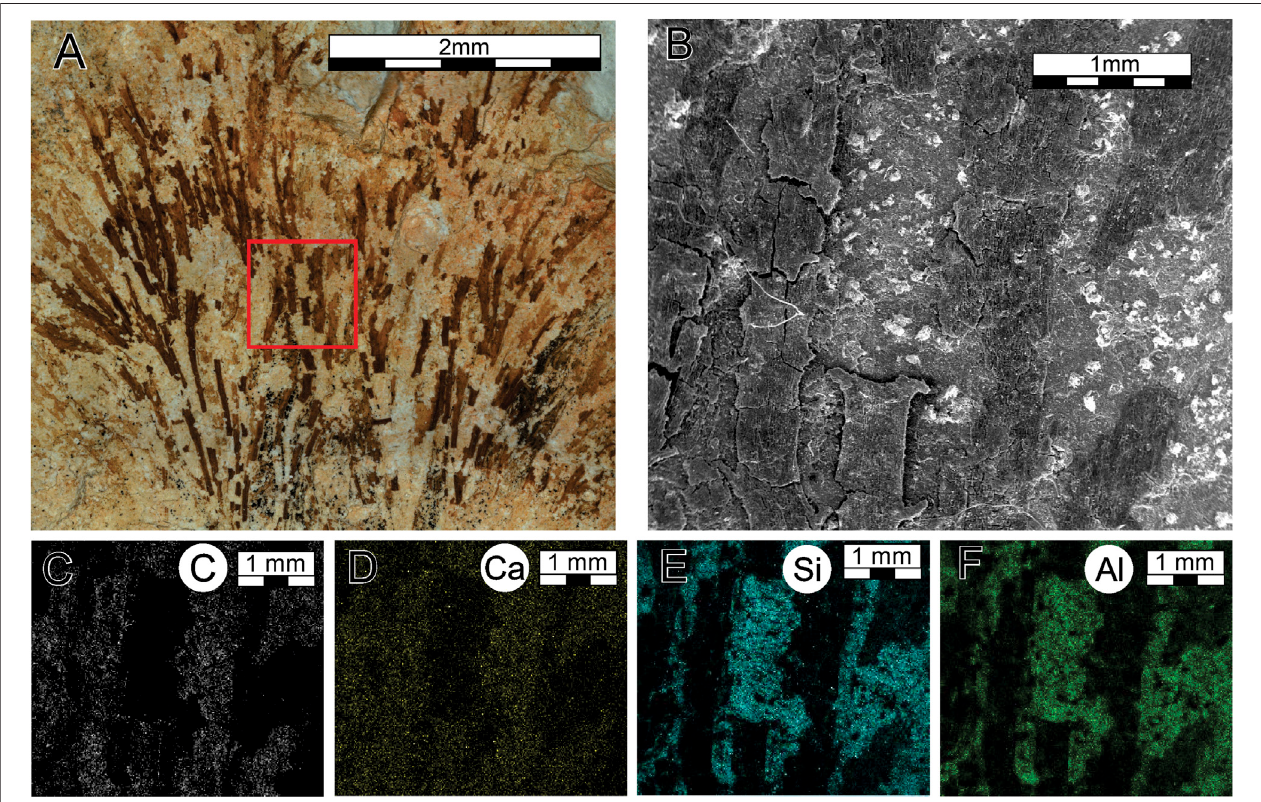
FIGURE5| AnalysisofSEMandEDSof T.espinosa . (A) Thecompletefossil,wheretheredsquarehighlightsthezoommadeinimage (B) . (B) AnalysisofSEM. (C) Concentration of carbon. (D) Concentration of calcium. (E) Concentration of silica. (F) Concentration of aluminum.